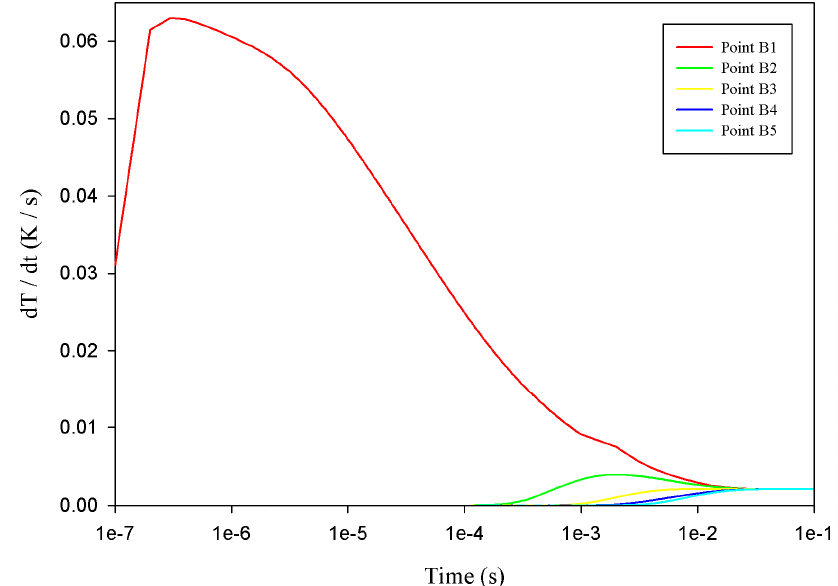
Figure 10. Simulated relationship between temperature variation rate (dT/dt) and time in the PZT material at points B1 to B5 for a mesh top electrode with a 100 μ m electrode width.